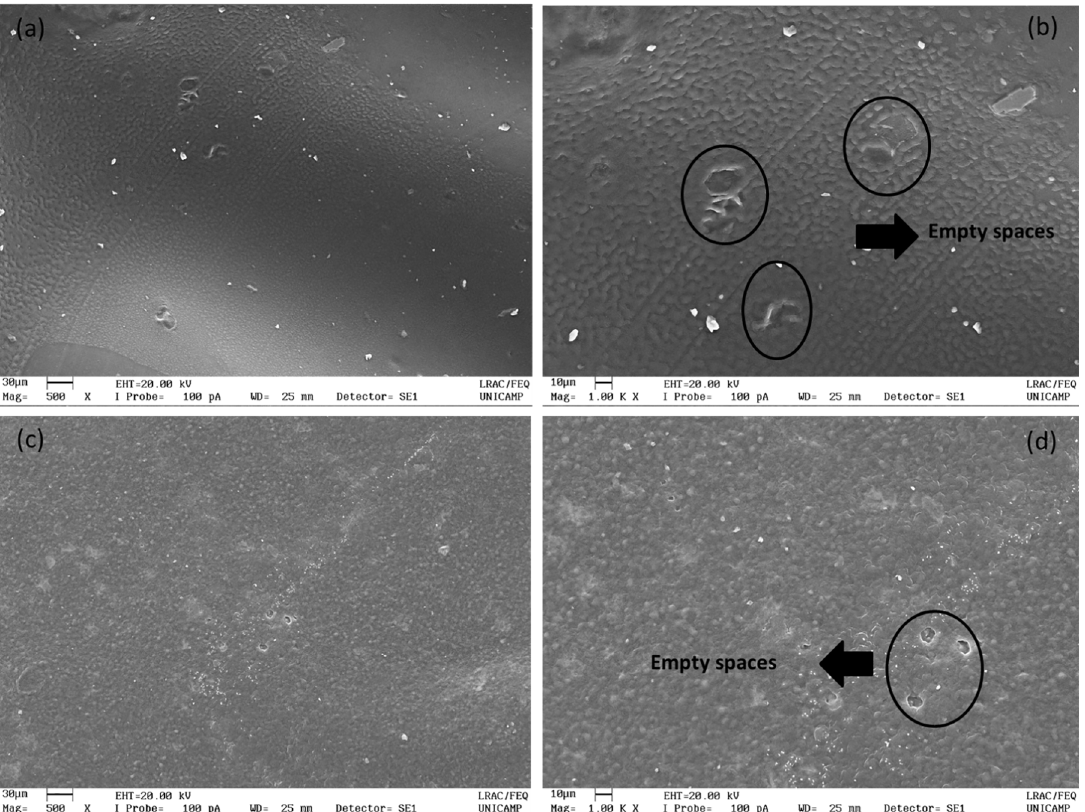
Figure 8. Scanning electron micrographs of (a) CHI-GE before antibacterial test (500x); (b) CHI-GE (1000x) after antibacterial test; (c) 1/2 mPEG-PCL/CHI-GE before antibacterial test (500x) and (d) 1/2 mPEG-PCL/CHI-GE after antibacterial test (1000x).